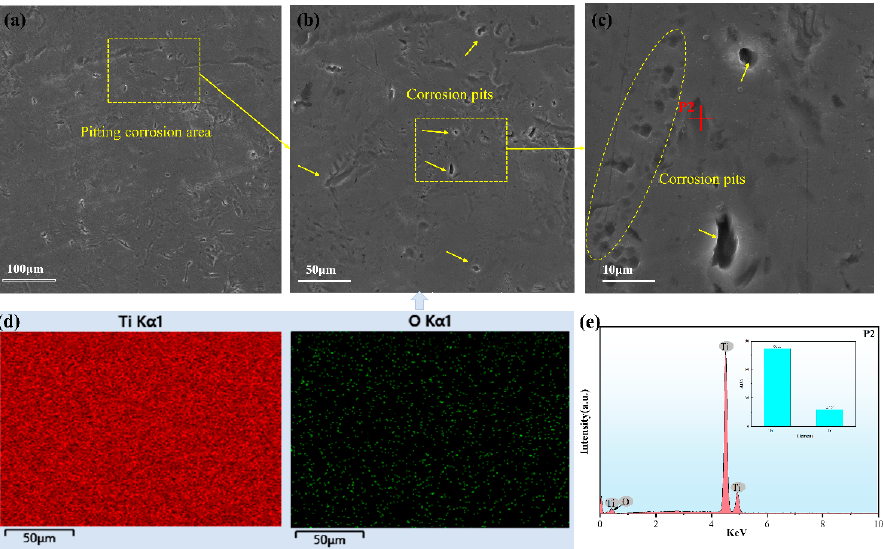
Figure 9. SEM and EDS point sweep after Ti corrosion. ( a – c ) SEM micrograph of Ti2 after corrosion; ( d ) EDS Analysis of Element Distribution on Ti2 Surface.; ( e ) EDS analysis of P2 point.